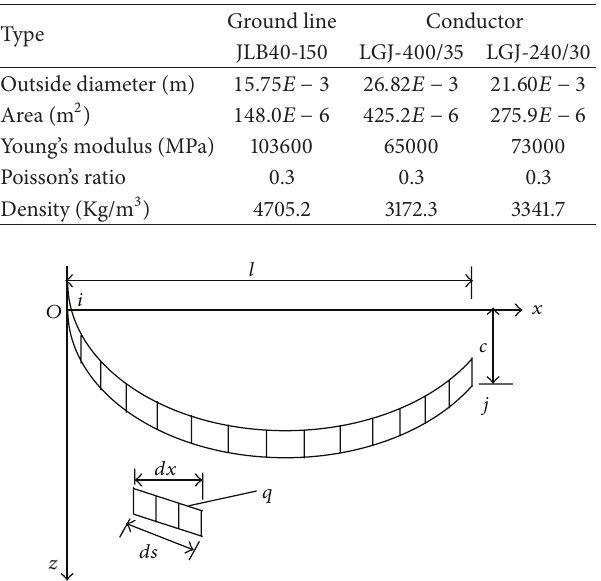
Table 2: Ground line and conductor properties of the tension type.